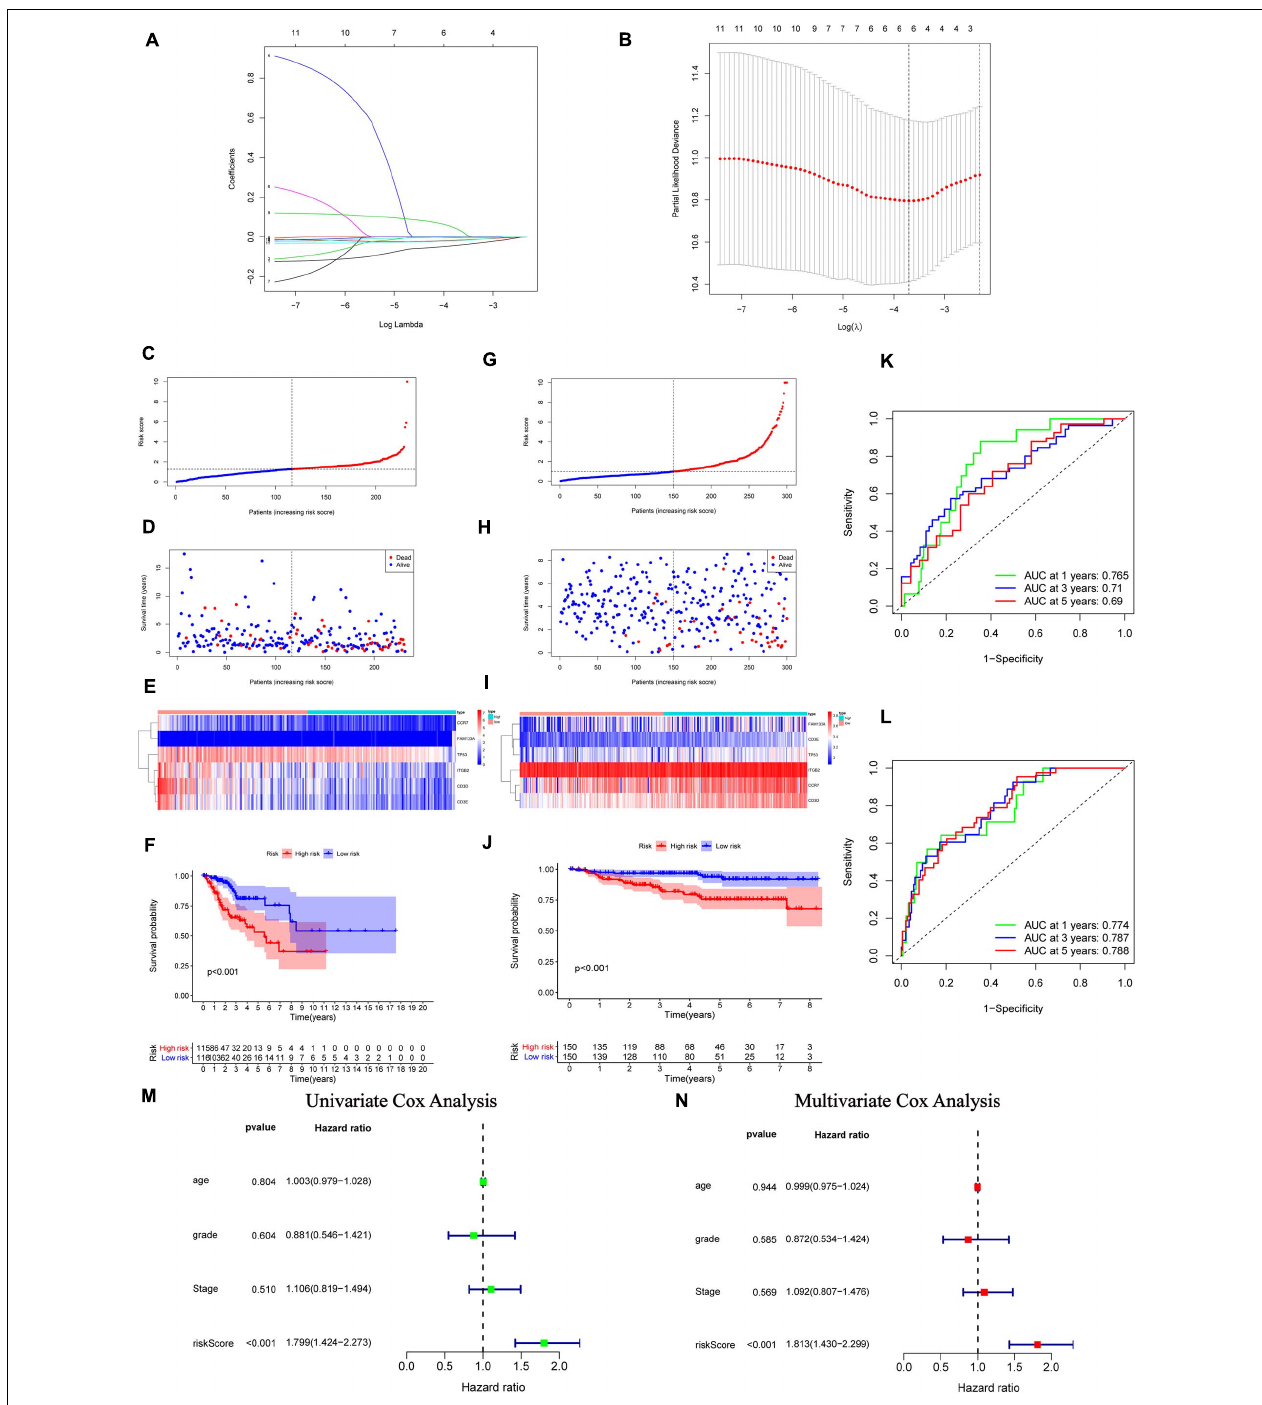
FIGURE 5 | Construction, validation, and assessment of the immune-gene related prognostic model (IGRPM) using TCGA and GEO datasets. (A , B) Identification of prognostic genes using least absolute shrinkage and selection operator (LASSO) regression analysis. (A) Coefficients of the LASSO regression analysis. (B) Selection of tuning parameters based on the 1000 cross-validations method. (C–F) TCGA set, the distribution of the risk score in panel (C) , recurrence status in panel (D) , gene expression panel in panel (E) , and Kaplan-Meier curves of overall survival (OS) in patients with CC based on the risk score in panel (F) . (G–J) GEO validation set, the distribution of the risk score in panel (G) , recurrence status in panel (H) , gene expression panel in panel (I) , and Kaplan-Meier curves of OS in patients with CC based on the risk score in panel (J) . (K) Receiver operating characteristic (ROC) curve analysis of the IGRPM or prediction of recurrence risk at 1, 3, and 5 years in TCGA dataset. (L) ROC analysis of the IGRPM or prediction of recurrence risk at 1, 3, and 5 years in the GEO dataset. (M) Univariate Cox regression analyses of OS. (N) Multivariate Cox regression analyses of OS.